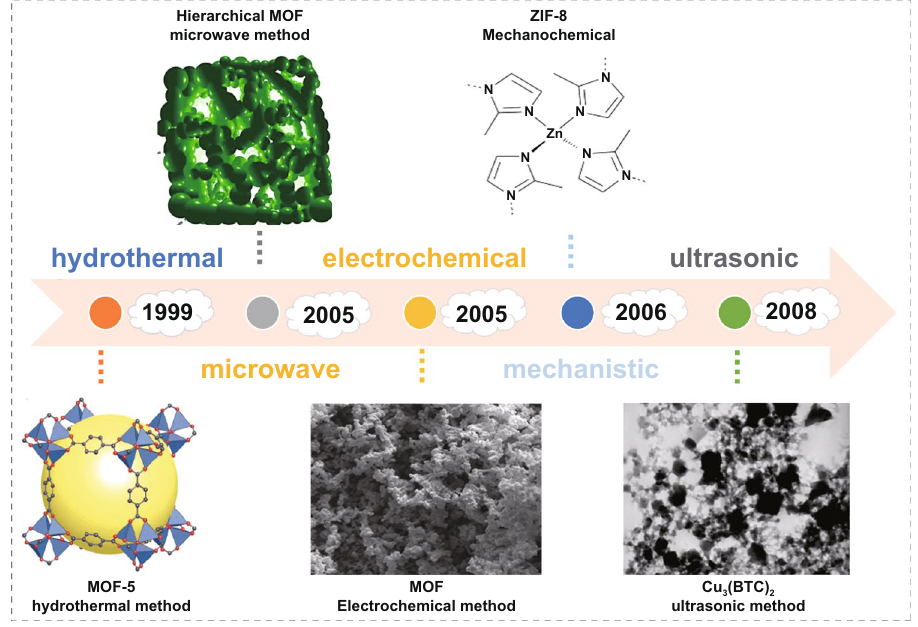
Fig. 3 Timeline of the traditional one-pot synthesis. Reprinted with permission from Ref. [63, 68, 70–72]. Copyright @1999 Macmillan Maga- zines Ltd. @2006 Royal Society of Chemistry, @ 2008 Elsevier, @ 2020 American Chemical Society, @ 2015 Nature Publishing